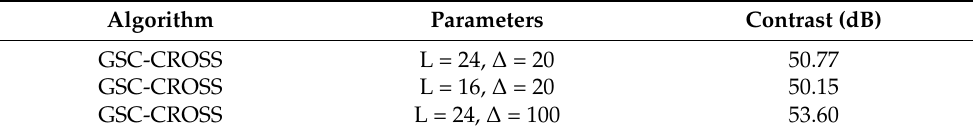
Table 5. Contrast of beamforming responses of GSC-CROSS with different